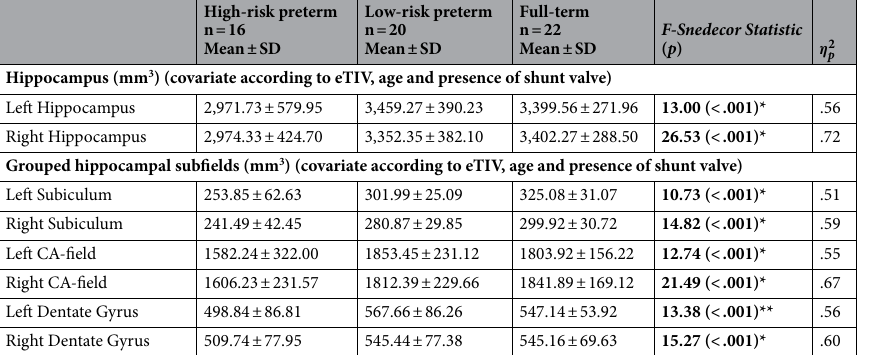
High-risk preterm n = 16 Hippocampus (mm 3 ) (covariate according to eTIV, age and presence of shunt